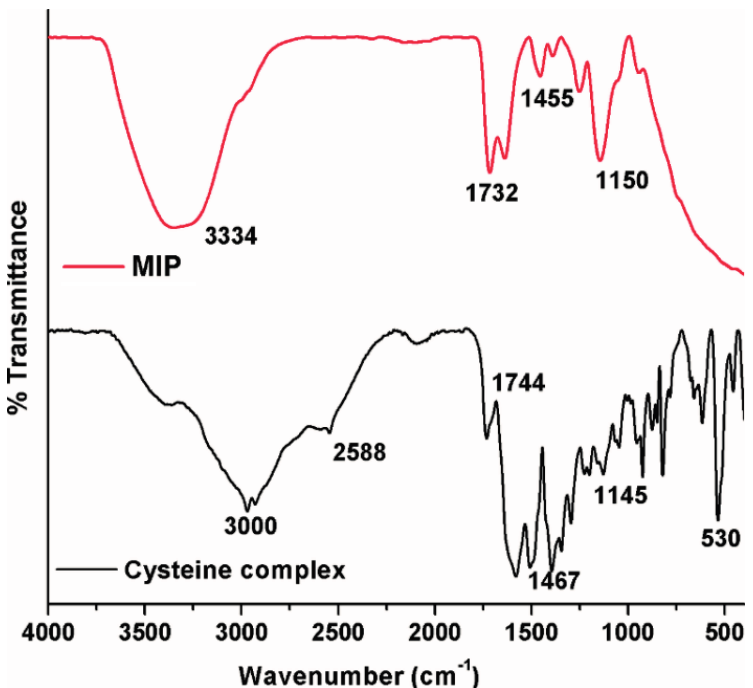
Figure 1. Comparison of FTIR spectra of the cysteine complex and the molecularly-imprinted polymer (MIP) Hg(II)-cysteine